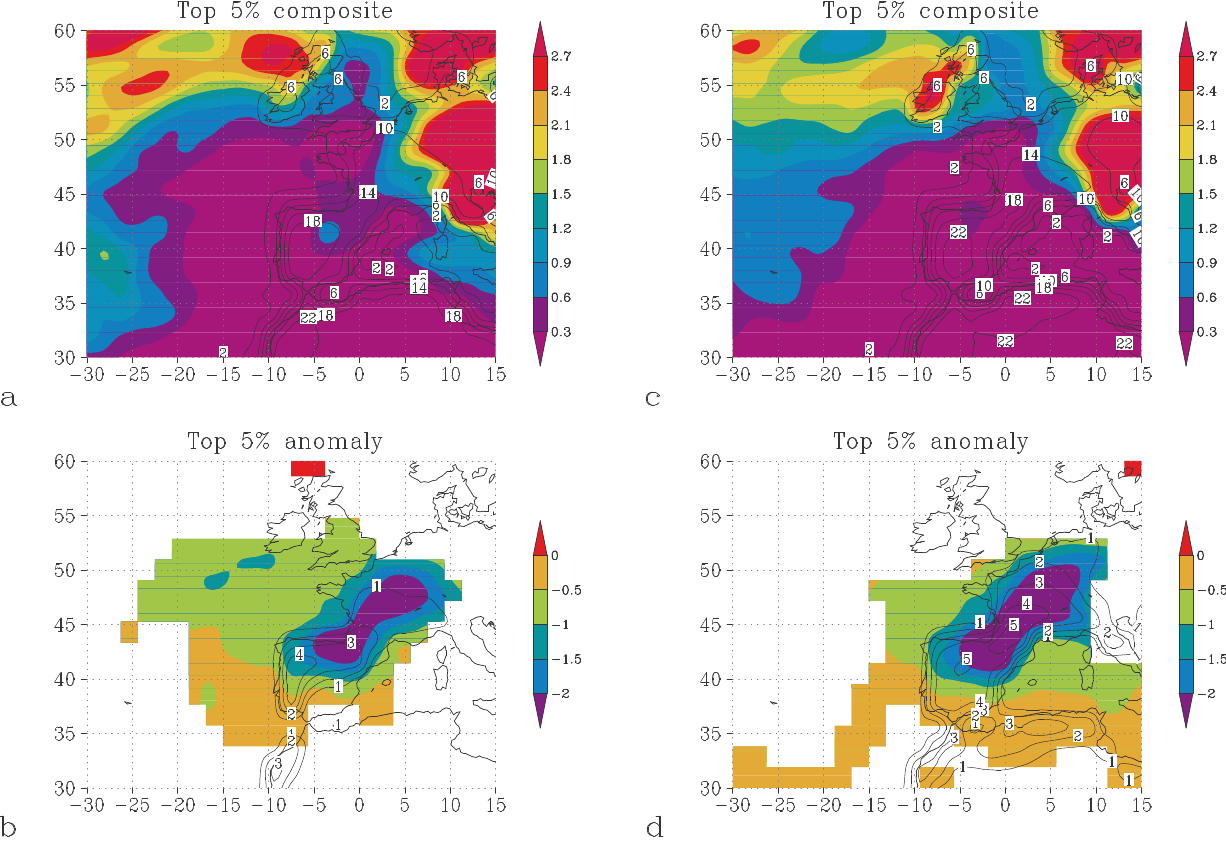
Fig. 8. Composite of precipitation rate in shaded colour (mm/day). For ( a ) Lisbon and ( c ) Madrid. Contour lines show the associated temperature range T max -T min field ( ◦ C), at 2-m height. The corresponding top 5% anomaly composites, after removing the summer average, are represented in b) Lisbon and ( d ) . The precipitation rate anomaly field is represented only in those areas where such an anomaly is significant at the 5% level (or 95% confidence level) computed with a two-tailed